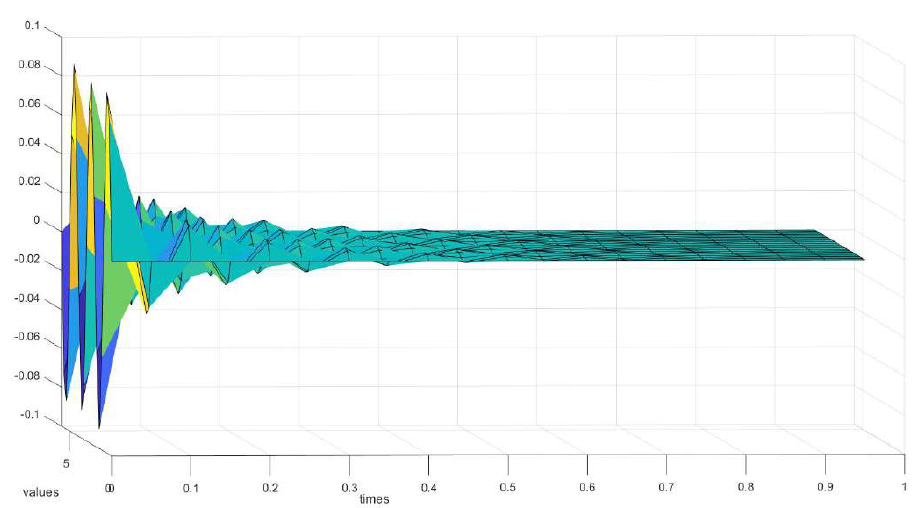
Figure 2. Convergence of solution u of (21)–(23) under control to zero in 3D.